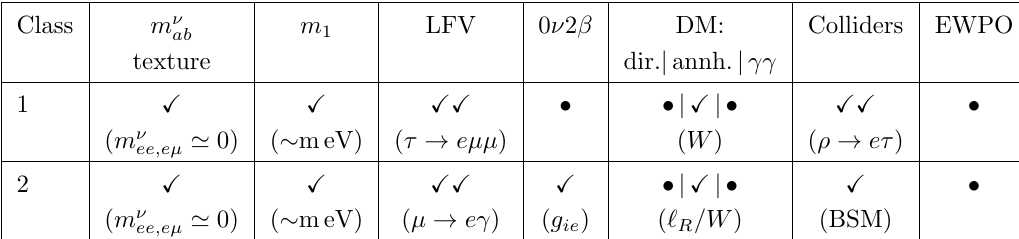
) for potential signals, ( X ) for key predic- (cid:15) texture: the ab